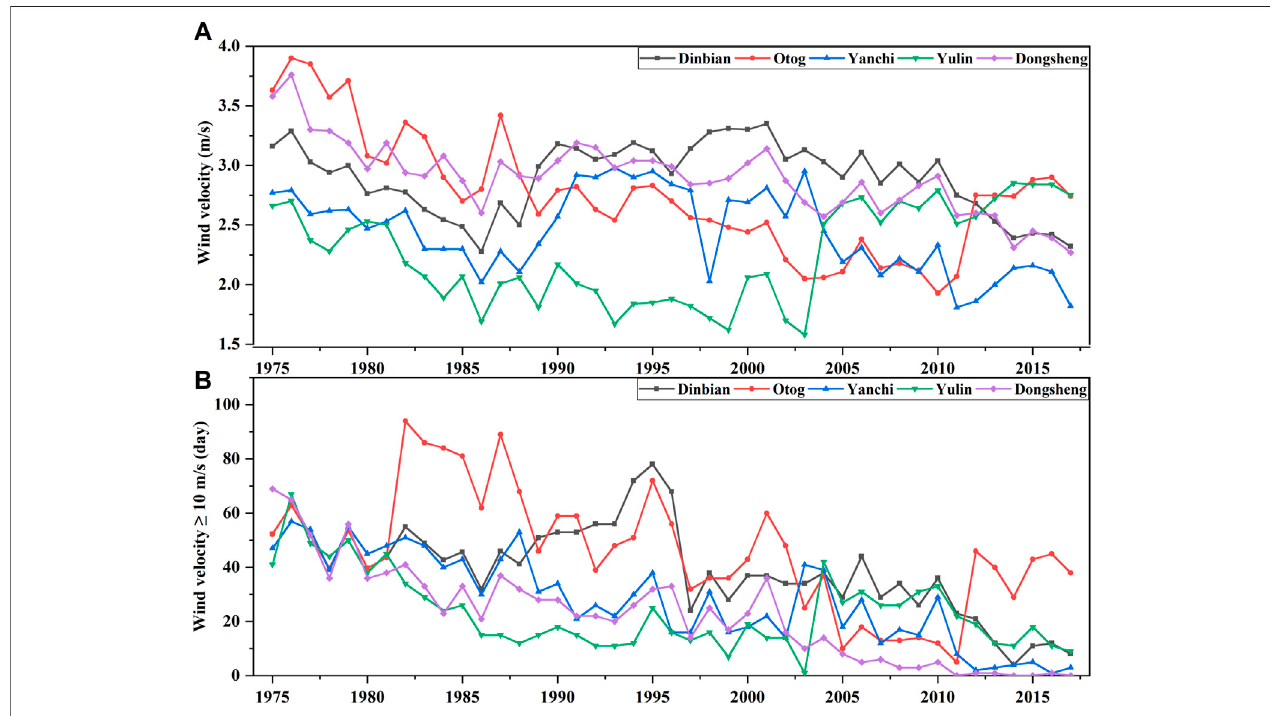
FIGURE 6 | (A) Annual average wind velocity, and (B) days with a wind speed higher than 10 m/s from 1975 to 2017 in Dinbian, Otog, Yanchi, Yulin and